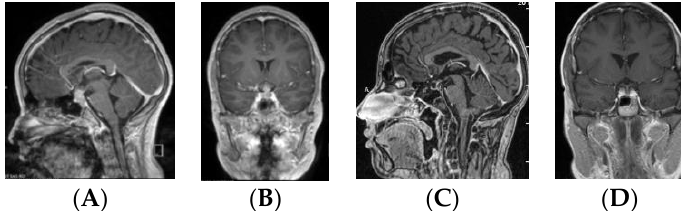
Figure 7. Thirteen-year-old male with suspected germinoma with high cerebrospinal fluid (CSF) β -HCG presenting with a one-month history of DI and monocular visual loss. Post-contrast MR, sagittal ( A ) and coronal ( B ) views showing an enhancing mass with Type II suprasellar lesion. Following pre-RT chemotherapy, the lesion resolved on postcontrast MR sagittal ( C ) and coronal ( D ) views. Note normal continuity of the pituitary stalk and atrophic pituitary gland.